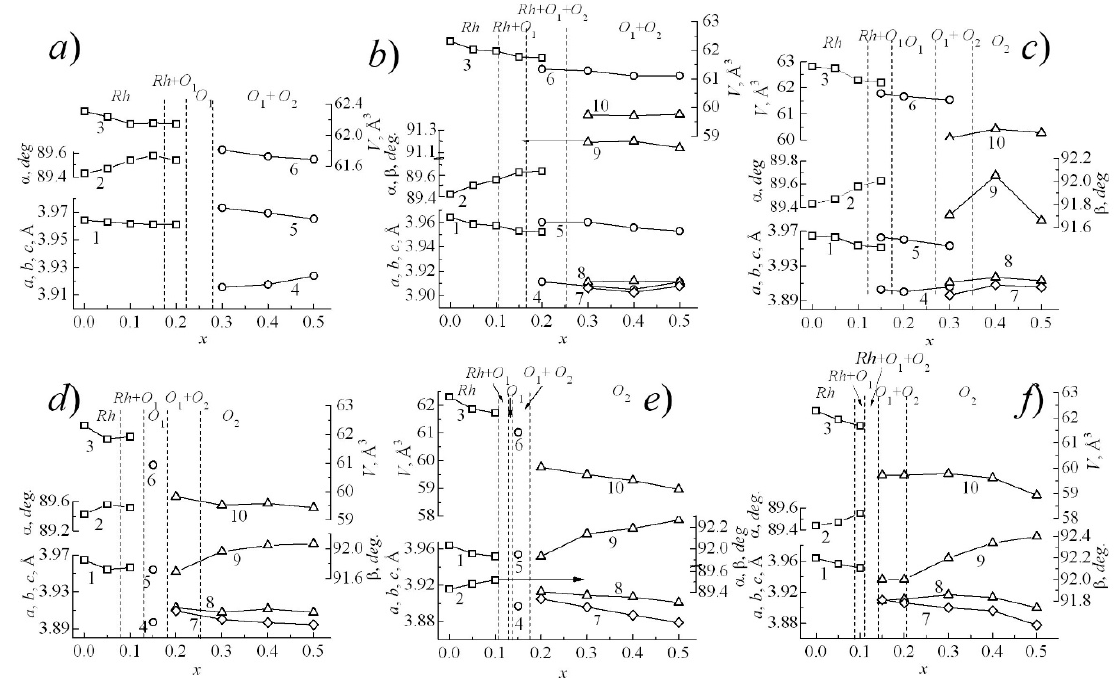
Figure 7. Dependences of the parameters of the perovskite cell of BiFeO 3 modified with La ( a ), Pr ( b ), Nd ( c ), Sm ( d ), Eu ( e ), Gd ( f ), respectively: 1, 2, 3– a , α , V –parameters and volume of rhombohedral cell ( Rh phase); 4, 5, 6– c , a , V –parameters and volume of the pseudotetragonal cell (orthorhombic phase O 1 of the PbZrO 3 type), 7, 8, 9, 10– b , a , β , V –parameters and volume of the monoclinic cell (orthorhombic phase O 2 of the type GdFeO 3 ).